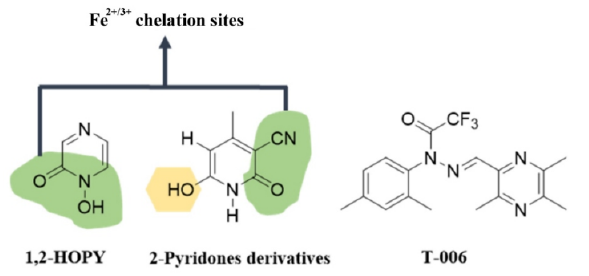
Figure 7. Structure of pyrazine and pyridones with neuroprotective activity. Green shadowing shows iron chelation sites; yellow shadowing shows free radical scavenger site. T-006 does not have a demonstrated metal chelation site nor anti-oxidant activity. Nonetheless, it has proven neuropro- tective activity.